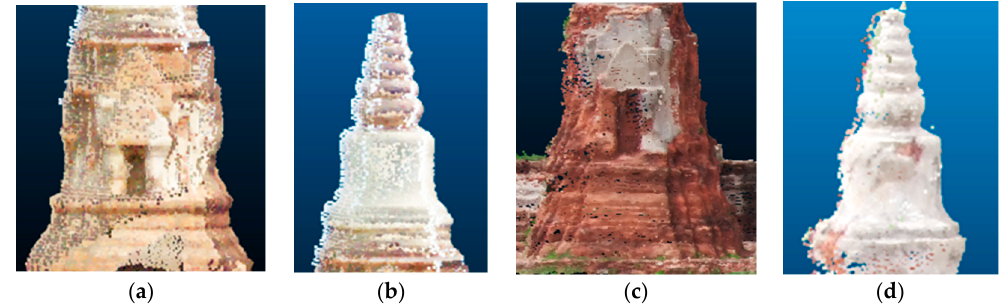
Figure 11. Comparison of the terrestrial and UAVs point cloud of the Chedi structure: ( a ) Base of the Chedi from TLS. ( b ) Top of the Chedi from TLS. ( c ) Base of the Chedi from UAV. ( d ) Top of the Chedi from UAV.